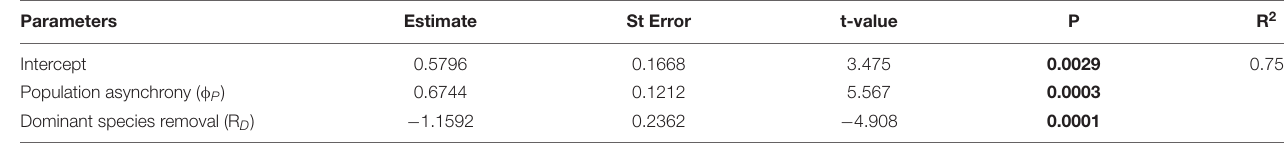
TABLE 4 | Summary results of the best performing model (Delta AICc < 6.0), including population asynchrony ( φ P ) and dominant species removal (R D ).